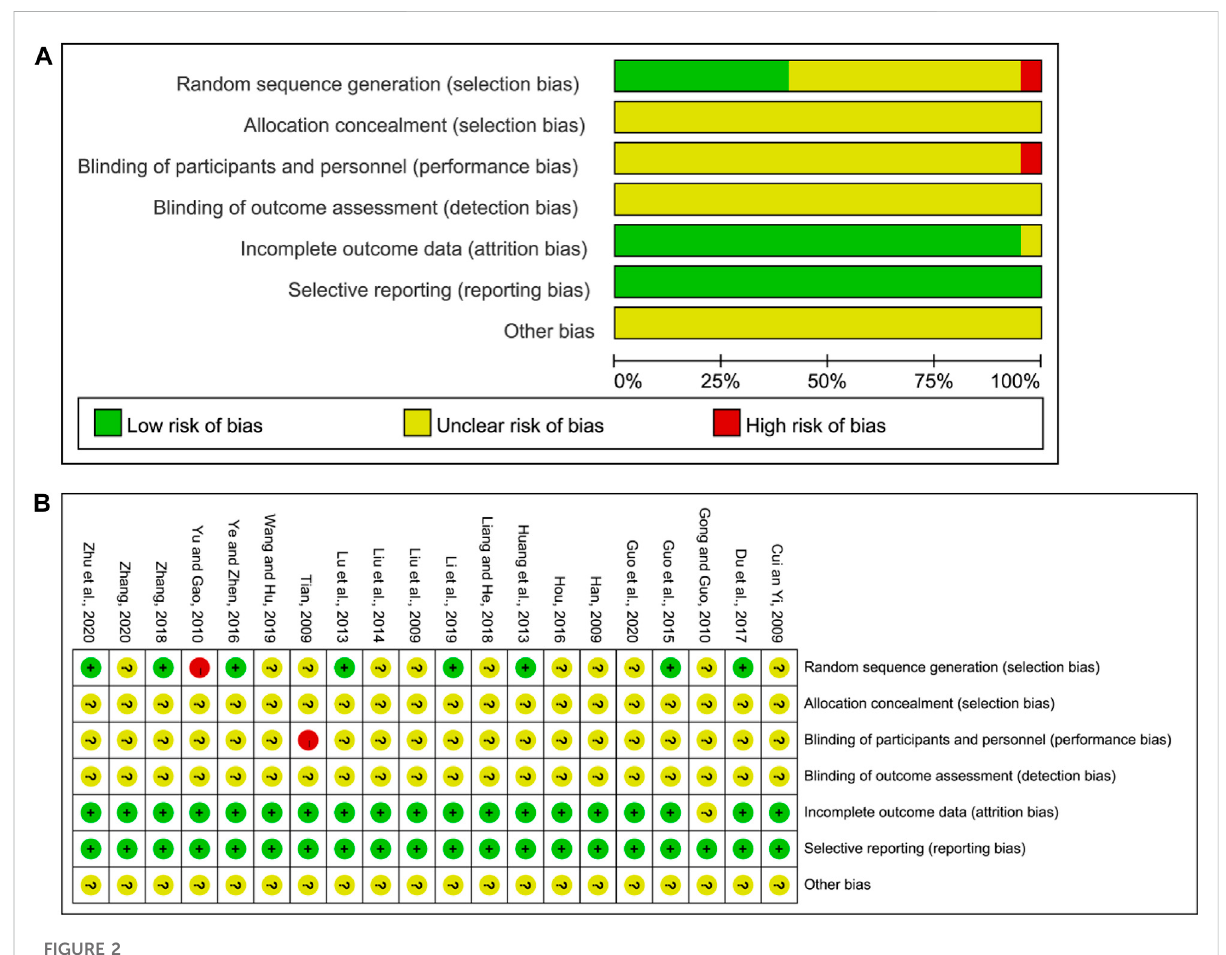
FIGURE 2 (A) Risk of bias graph and (B) risk of bias